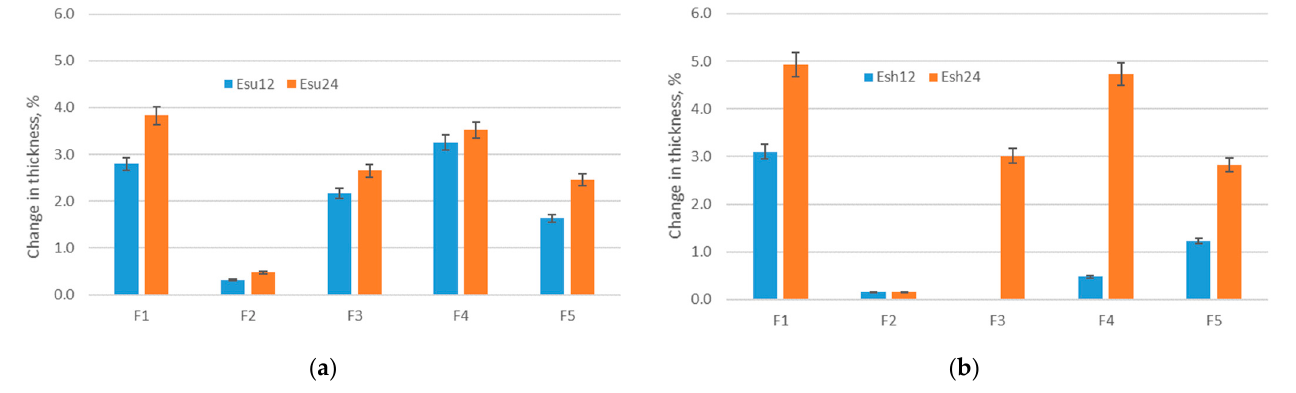
Figure 5. Change in material thickness due to exposure: ( a ) Esu; ( b ) Esh.